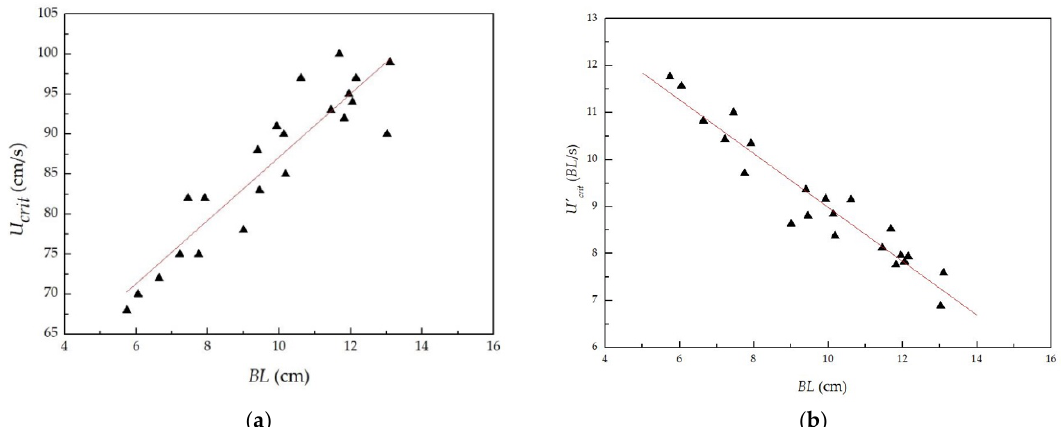
Figure 4. Relationship between absolute/relative critical swimming speeds and body lengths of tested juvenile grass carp: ( a ) Relationship between absolute critical swimming speeds and body lengths; ( b ) Relationship between relative critical swimming speeds and body lengths.